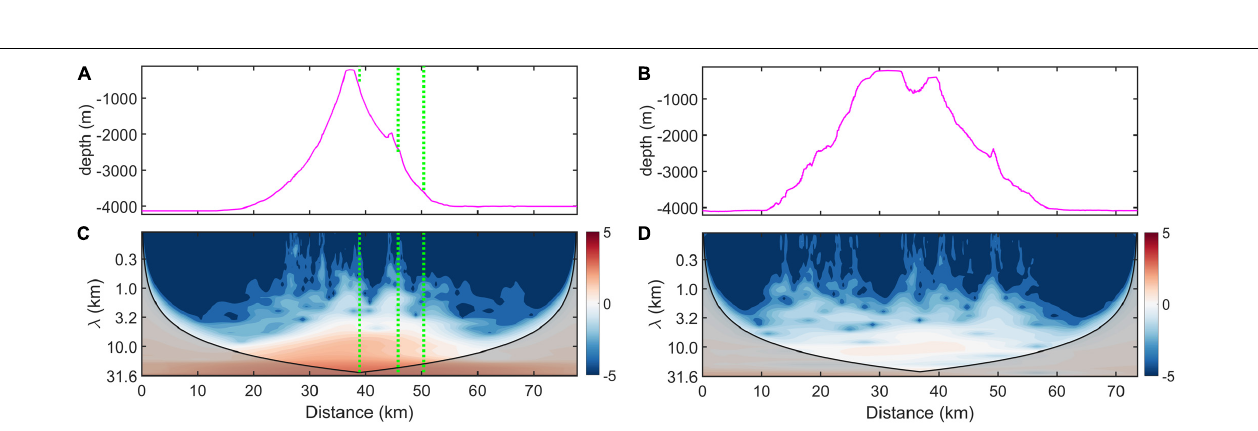
FIGURE 6 | Baroclinic internal tide components were acquired from the LADCP profiles cast along the south–north section of the seamount.